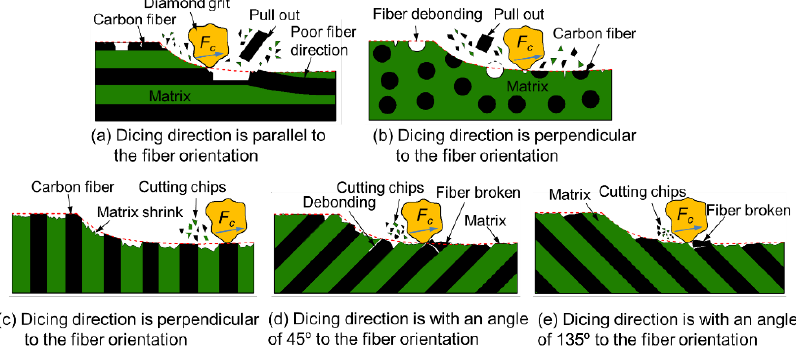
Figure 16. Schematic diagram of dicing mechanism with different fiber orientations.